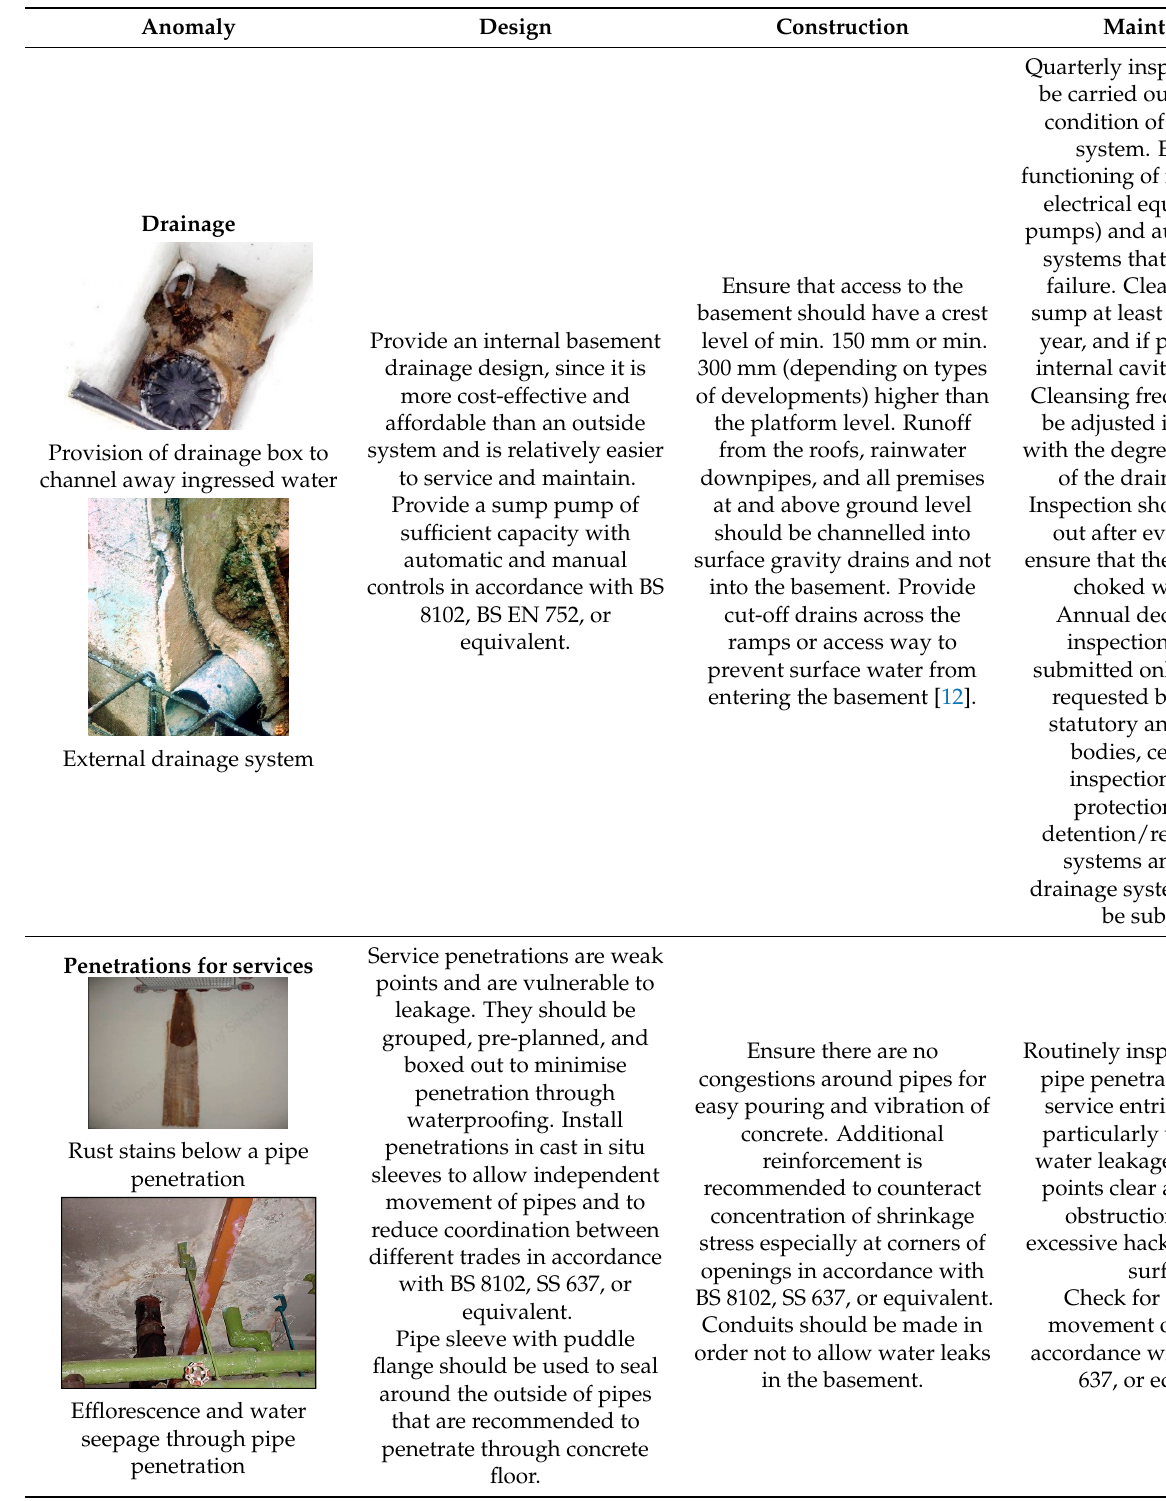
Table 4. Basements—Service components that include vertical and horizontal circulation systems, electro-mechanical connections, and sanitary